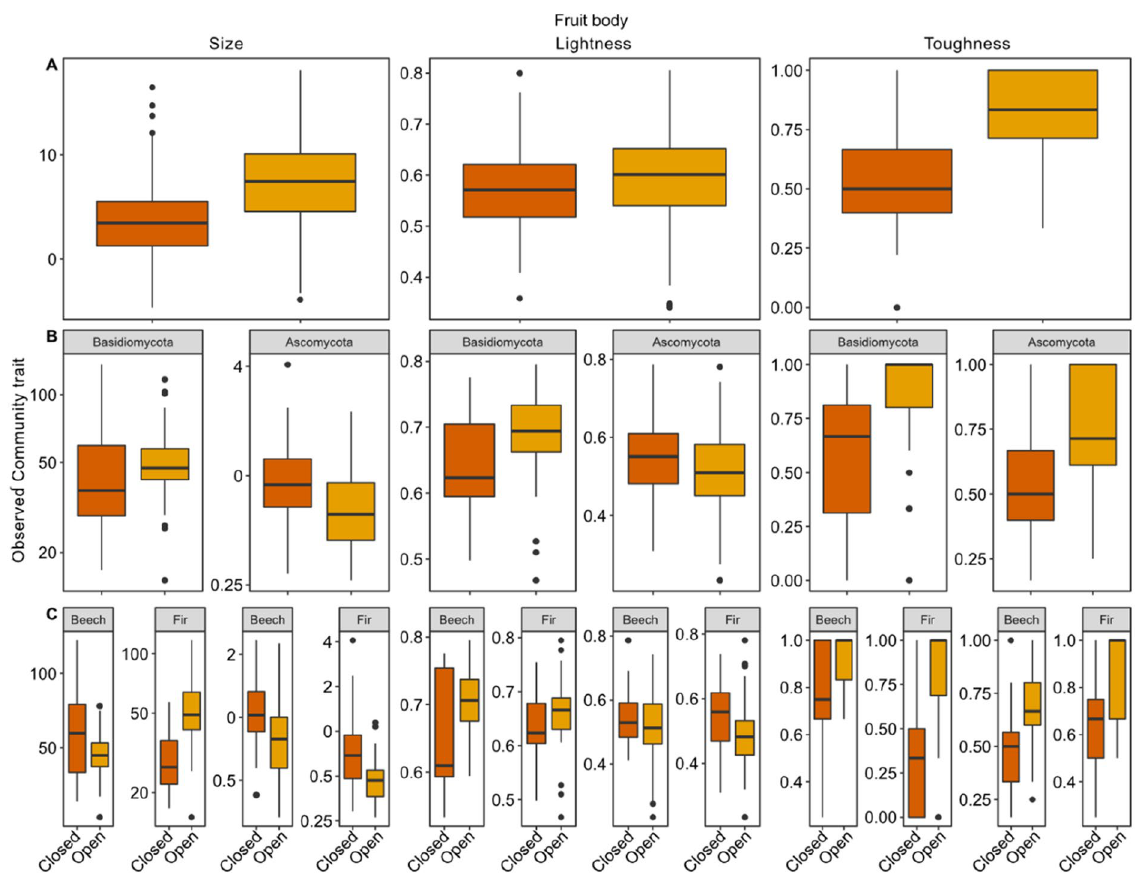
Figure 3. Response of the observed community traits with canopy openness. ( A ) Overall community trait response to canopy openness. Dark orange refers to closed canopies, light orange to open canopies. ( B ) Effects of canopy openness on the community trait separated for Basidio- and Ascomycota. ( C ) Effects of canopy openness on the community trait separated for lineages and tree species. For a statistics table based on a multivariate linear mixed-effects model, see Table 1. Note that fruit body size and color lightness were log 10 - transformed. The unit of fruit body size is millimetres, the unit of lightness and toughness is percentage. R programming environment version 4.1.2 40 and R add-on package ggplot2 41